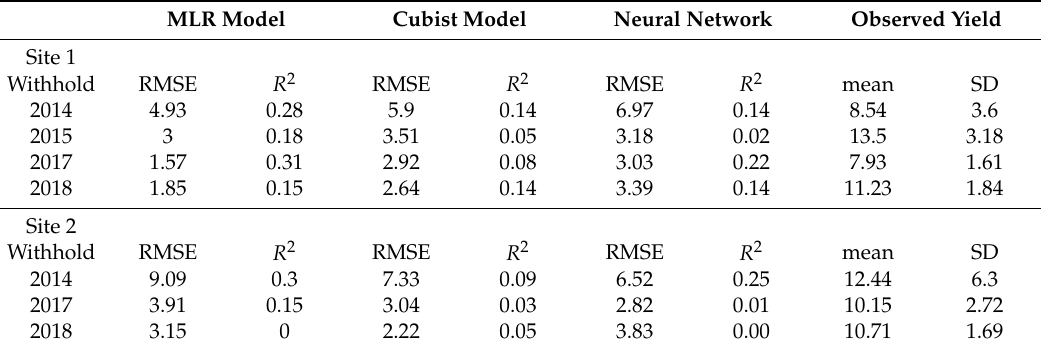
Table 7. Prediction results of the MLR and Cubist model in the leave-out-one-year analysis. MLR